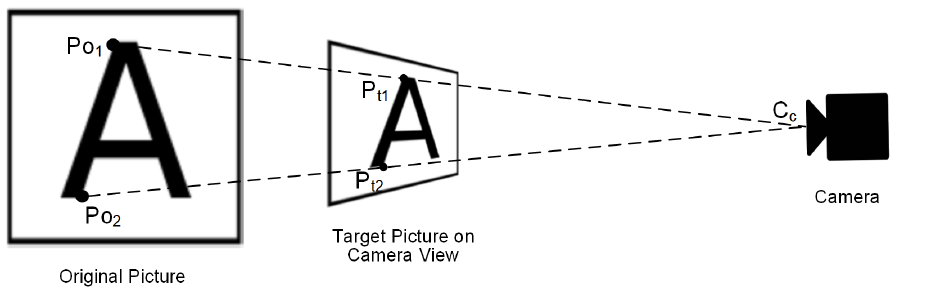
Figure 12. Matching Points